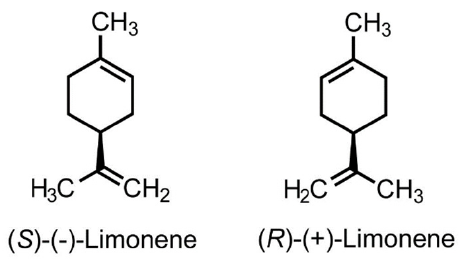
Figure 1. Structure of